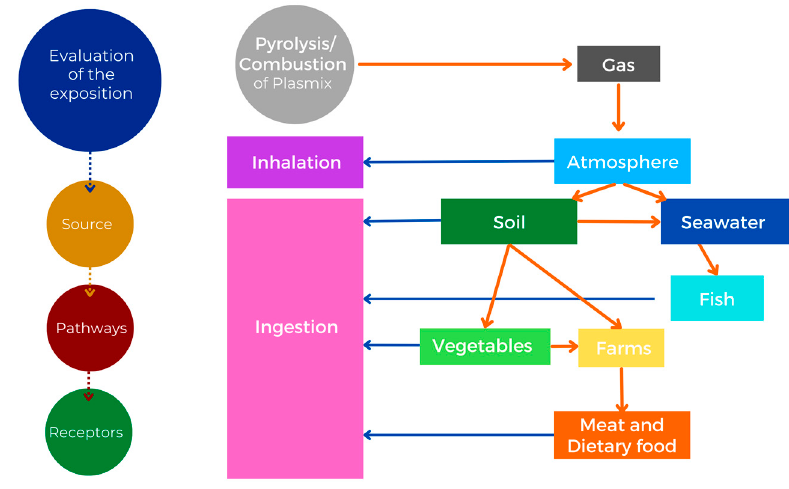
Figure 5. Scheme of the exposure pathways and routes.